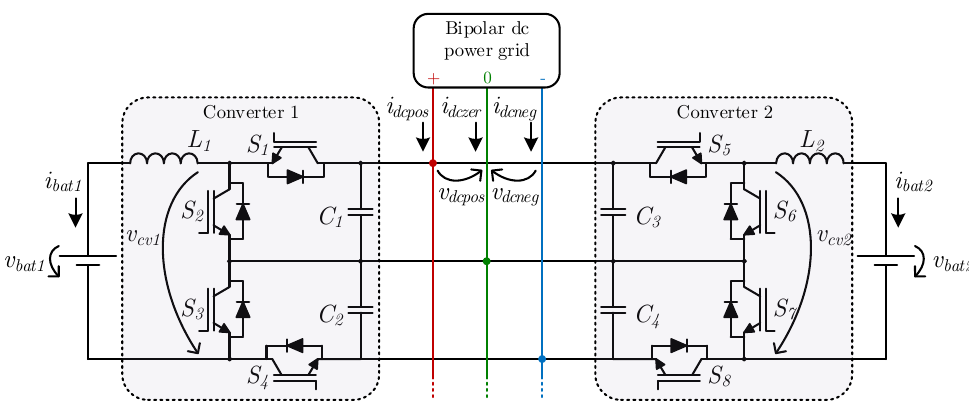
Figure 1. Power structure of the electric vehicle (EV) battery charging station